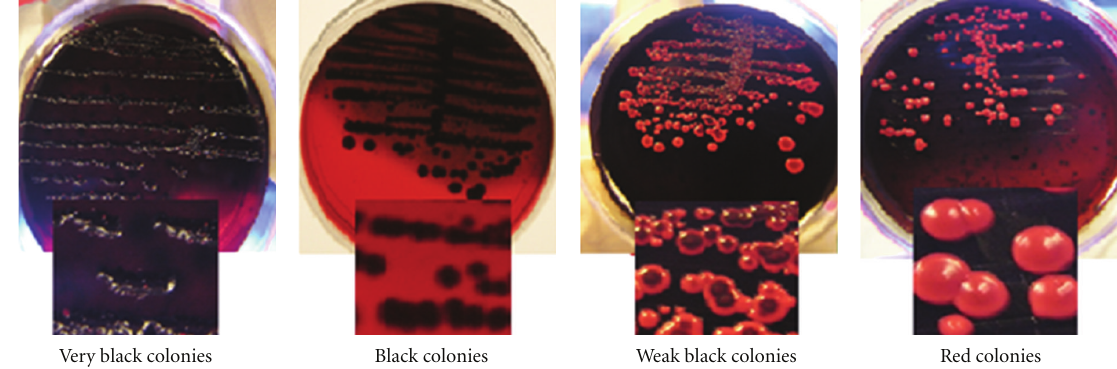
Figure 1: Colony morphologies of clinical S. aureus isolates on the modified Congo red agar